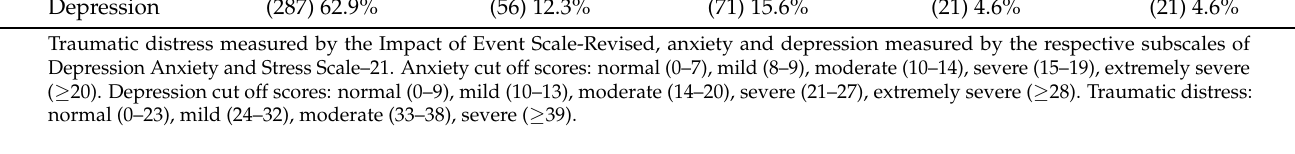
Table 3. Correlation matrix, means and standard deviations of all study variables ( n = 456).